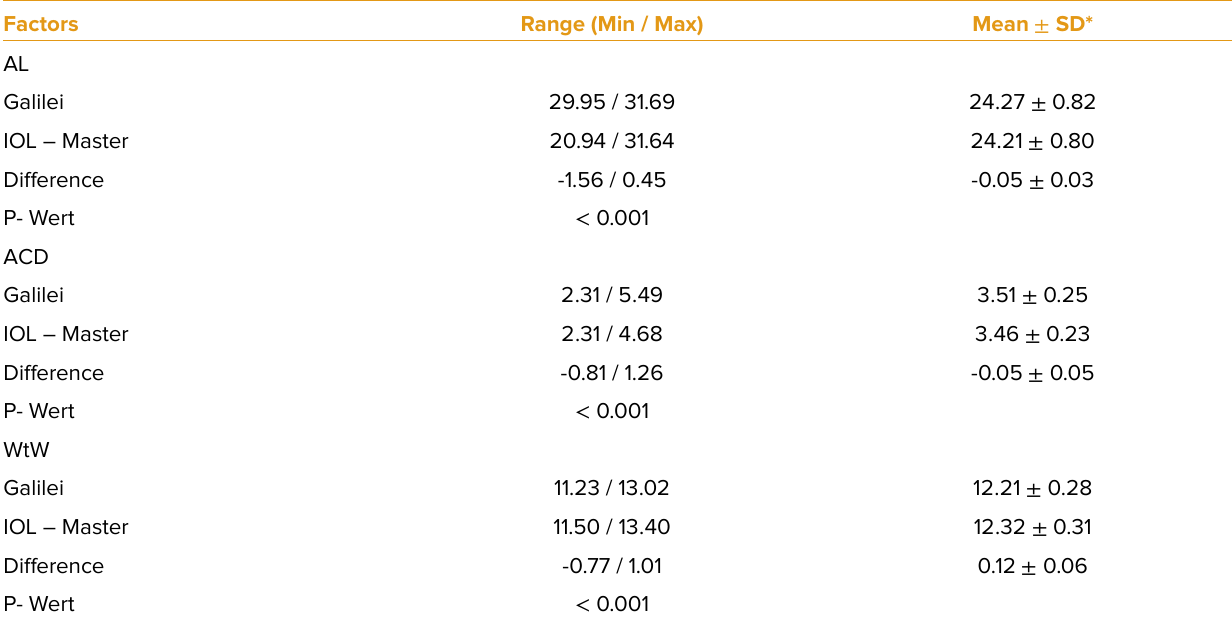
Table 1. Biometric standard